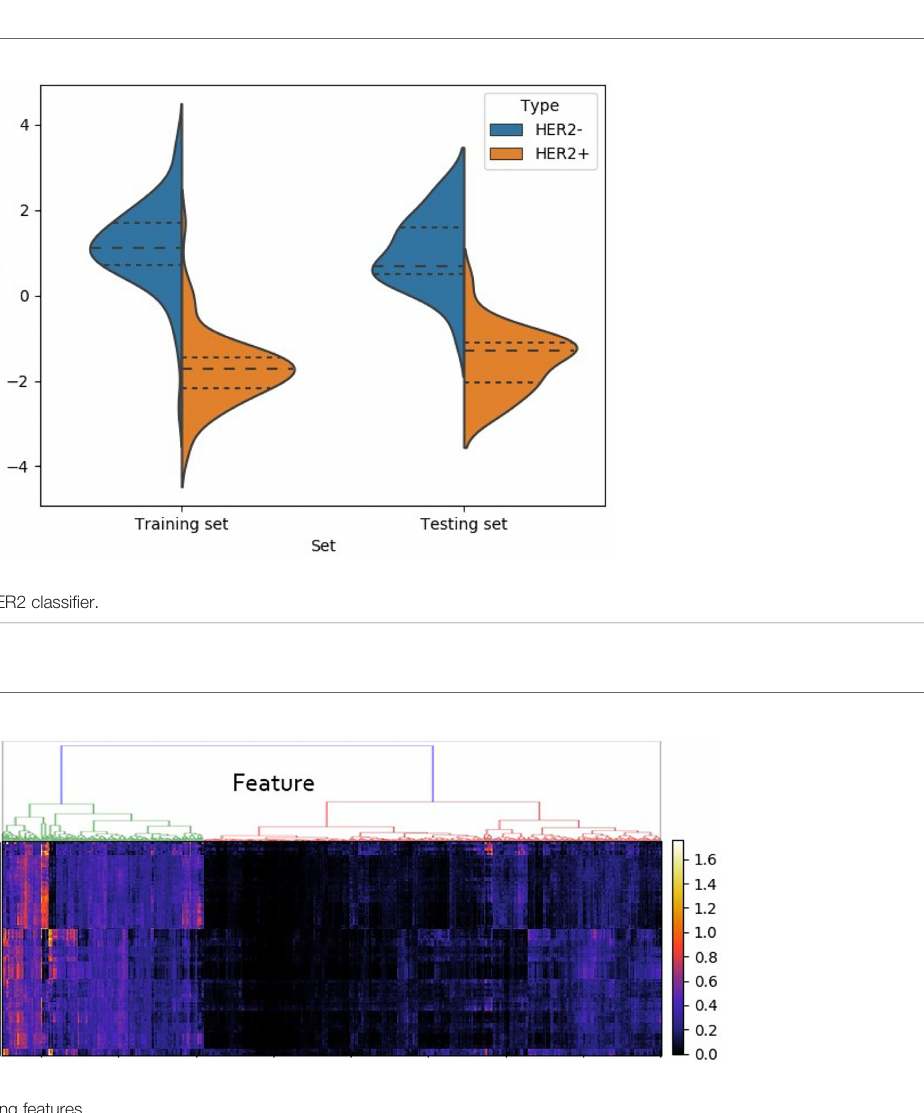
FIGURE 4 | Cluster analysis of deep learning features.